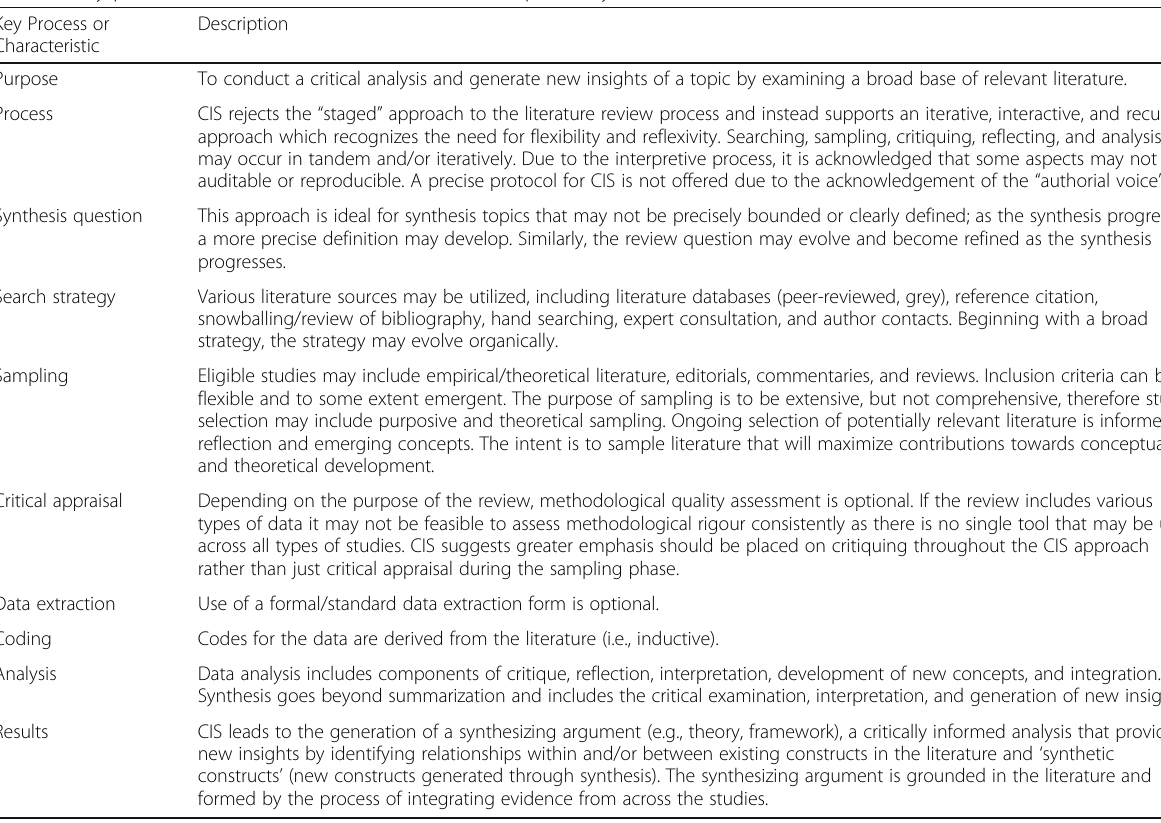
Table 1 Key processes and characteristics of a critical interpretive synthesis Key Process or